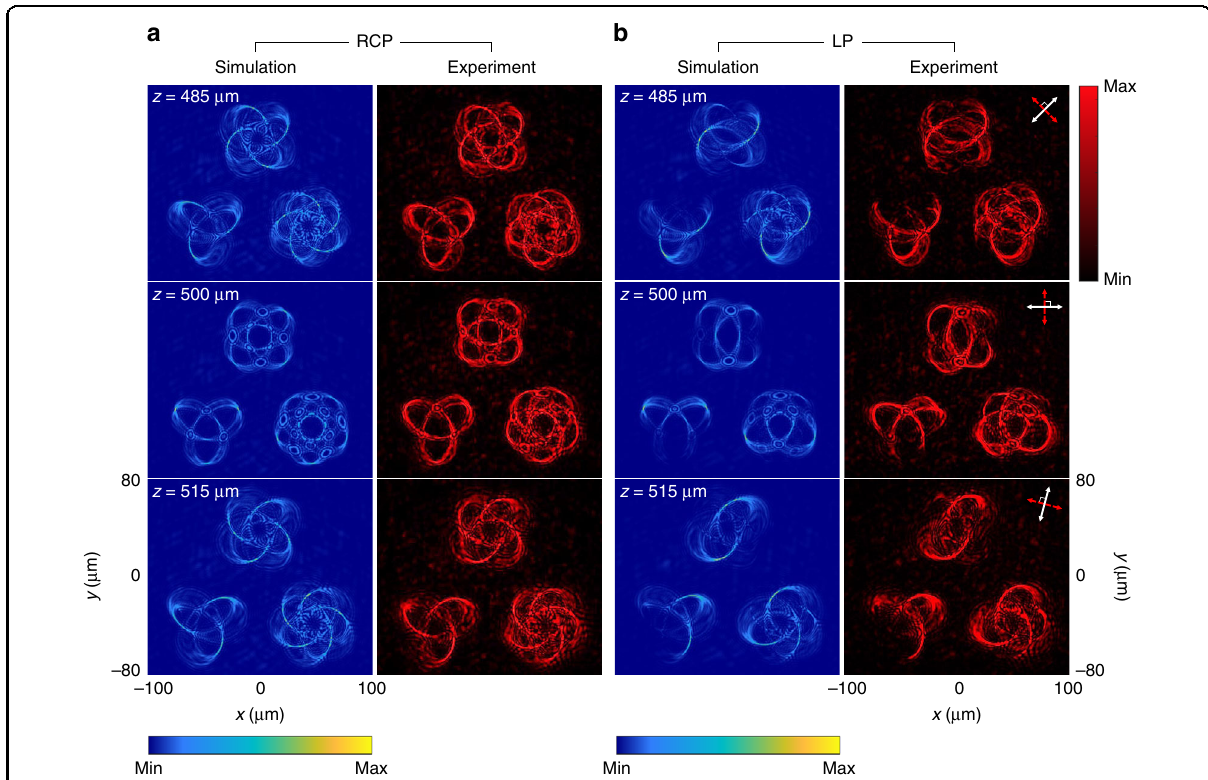
Fig. 3 Simulation and experimental results of the generated multiple 3D polarization knots at λ = 650 nm. a The intensity distributions at different observation planes under the illumination of RCP light beam. b The intensity distributions under the illumination of an LP light beam for polarization distribution detection with different transmission axes of the linear polarizer and the analyzer at different observation planes. The simulated (left) and measured intensity pro fi les (right) at three observation planes after passing through the analyzer by considering Malus ’ law with different combinations of the transmission axes of the polarizer and the analyzer. The white and red double arrows indicate the transmission axes of the fi rst polarizer (P1) and the analyzer (P2), respectively. P1 ⊥ P2. The direction of the white arrows: 45° ( z = 485 μ m), 0° ( z = 500 μ m), and 75° ( z = 515 μ m) w.r.t. the x